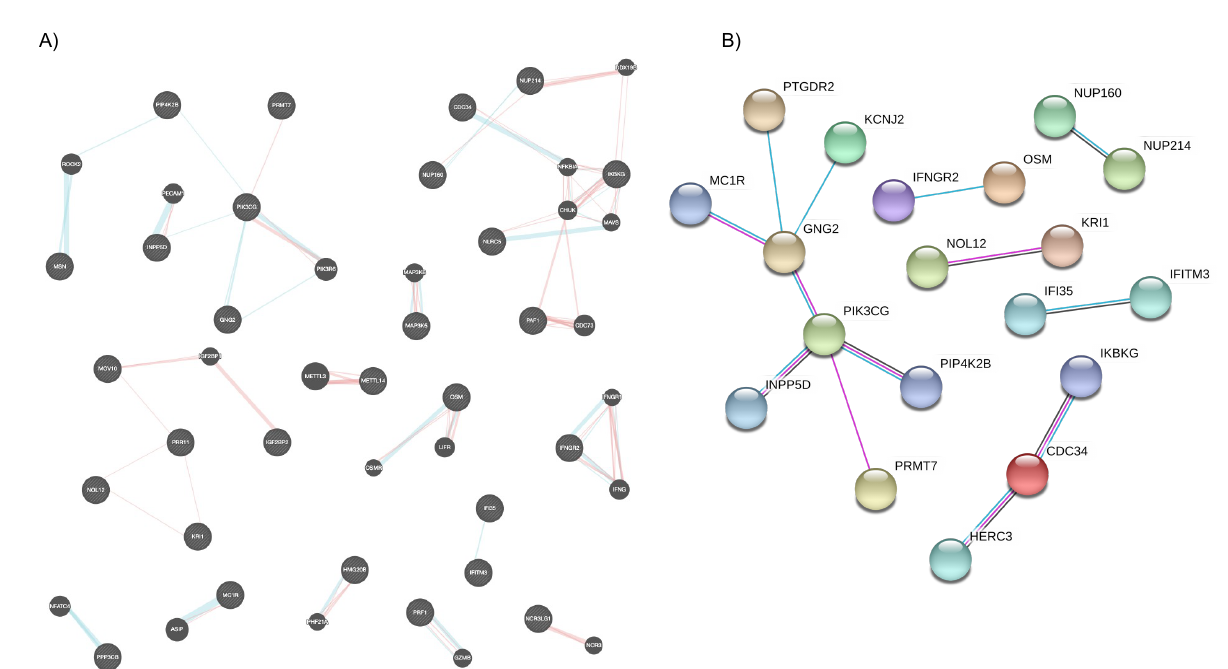
Figure 2. Key molecular processes are emphasized by network maps. ( A ) Network of relationships, weighted on biological process, among the differentially expressed genes (DEGs) induced by vitamin D3 (GeneMania). Edges denote physical interactions (orange) and pathways (blue). ( B ) Network of predicted protein–protein interactions inferred from the DEGs list (STRING). Edges shown depict known interactions based on knowledge from curated databases (blue edges), experimentally determined (pink edges), and co-expression data (black edges). A permalink is available for this network: https://version-11-0.string-db.org/cgi/network.pl?taskId=pagJWFiaVstn, accessed on 13 April